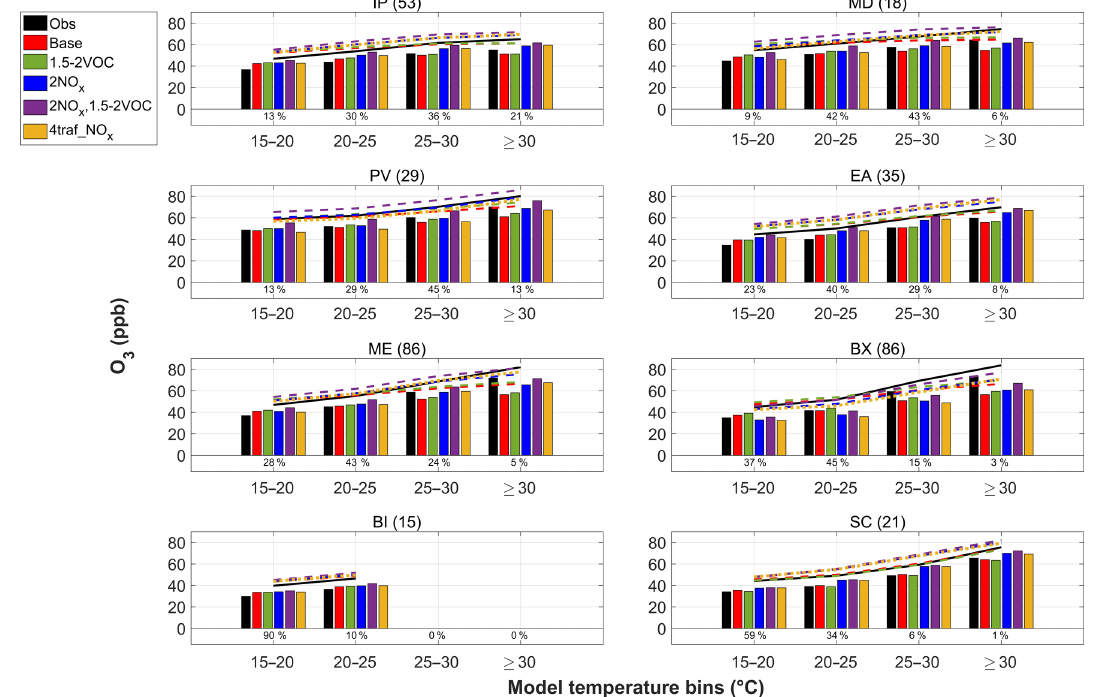
Figure 10. Afternoon (12:00–18:00UTC) surface O 3 mixing ratios for each modeled temperature bin for various emission scenarios in eight European regions in summer 2010. Colored lines show the trends of the respective bars and are shifted up by 10ppb for visualization purposes. Percentage values below the bars indicate the fraction of the values assigned to each bin for each region. The number of stations available for each region is reported in parentheses at the top of each panel. A definition of the regions is given in Fig.